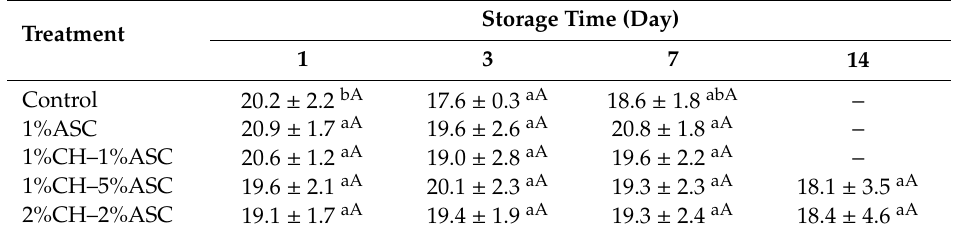
Table 2. Changes in the firmness (N) values of fresh cut apples during storage at 5 ◦ C *.